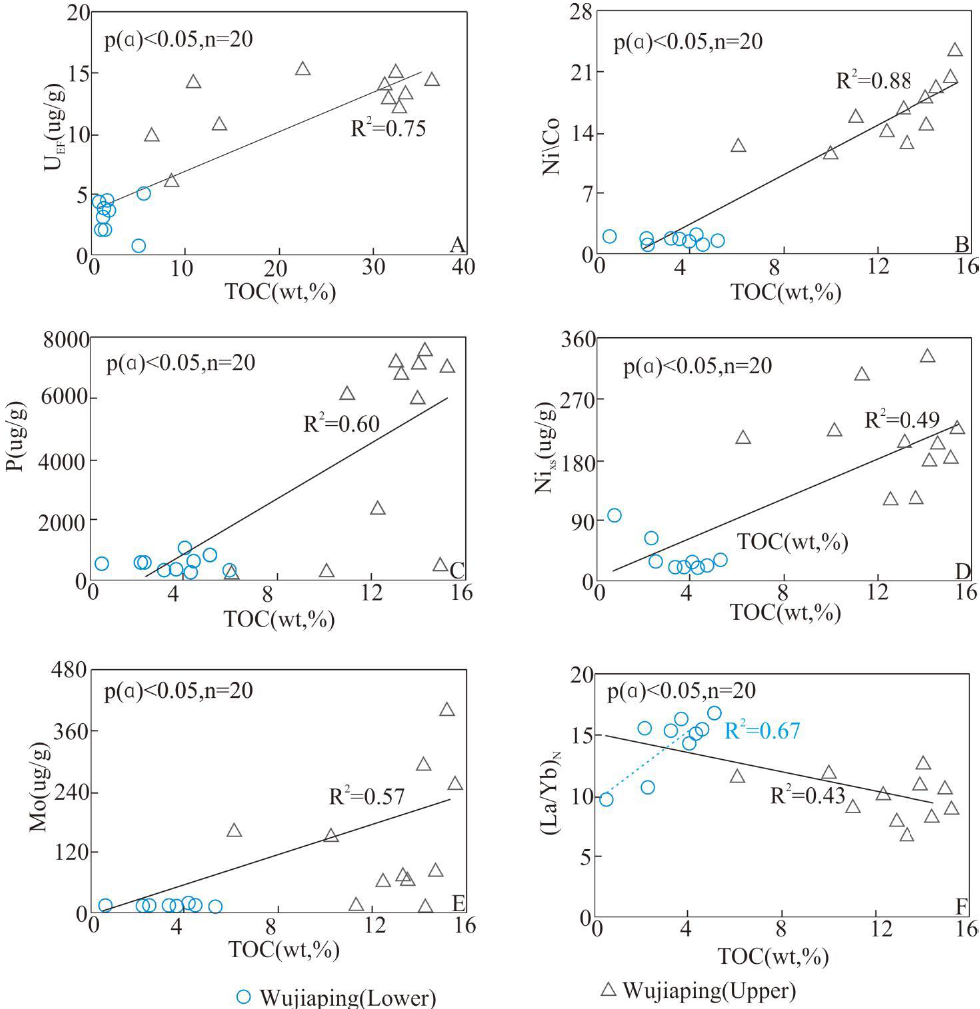
Figure 7. The figure of the correlation between the content of TOC and redox elements’ concentra- tion (U EF , Ni/Co), indicators of paleoproductivity (P, Nixs, Mo), and the deposition rate (La/Yb) N .